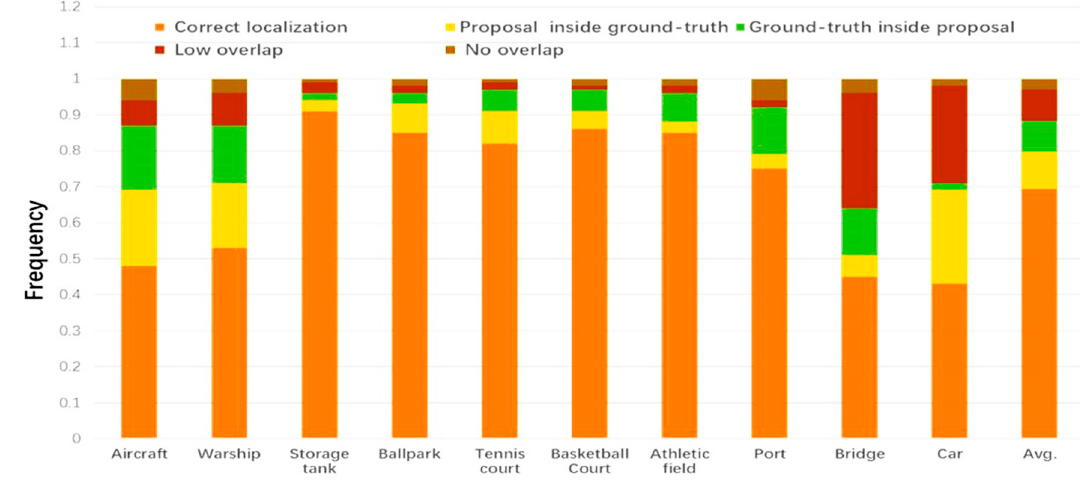
Figure 7. Per-class frequency of error modes as well as average error across all classes for the AD-FCN.